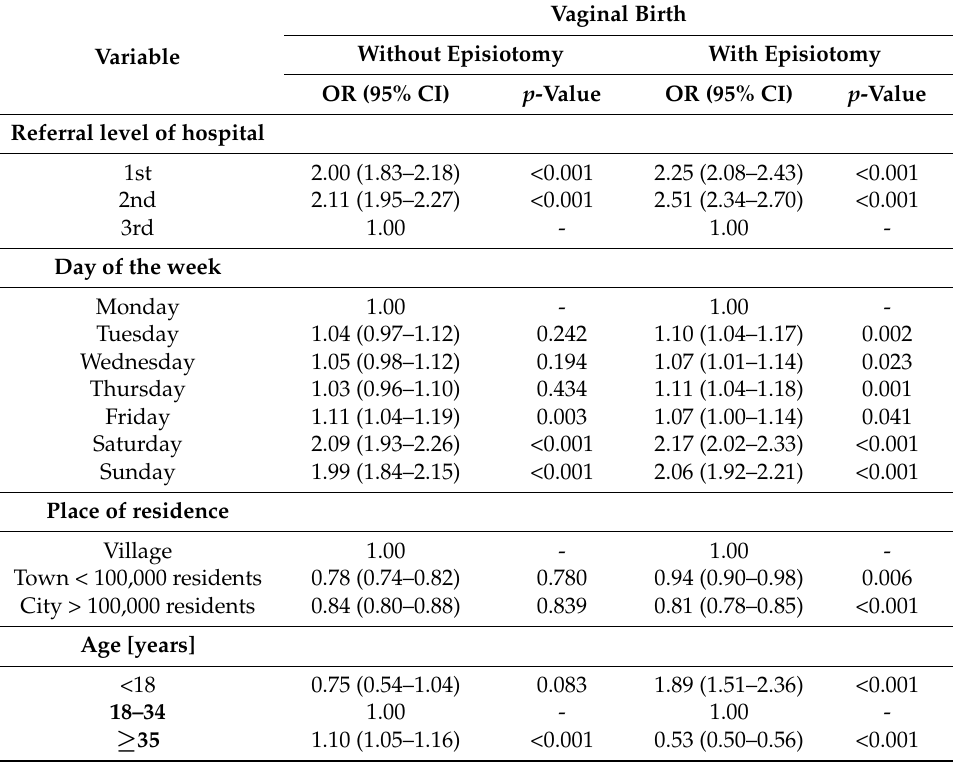
Table 5. Factors modifying the chances of normal childbirth and normal birth with episiotomy in comparison with birth by C-section in the years 2013–2014 in the Malopolska province. OR: odds ratio; CI: confidence